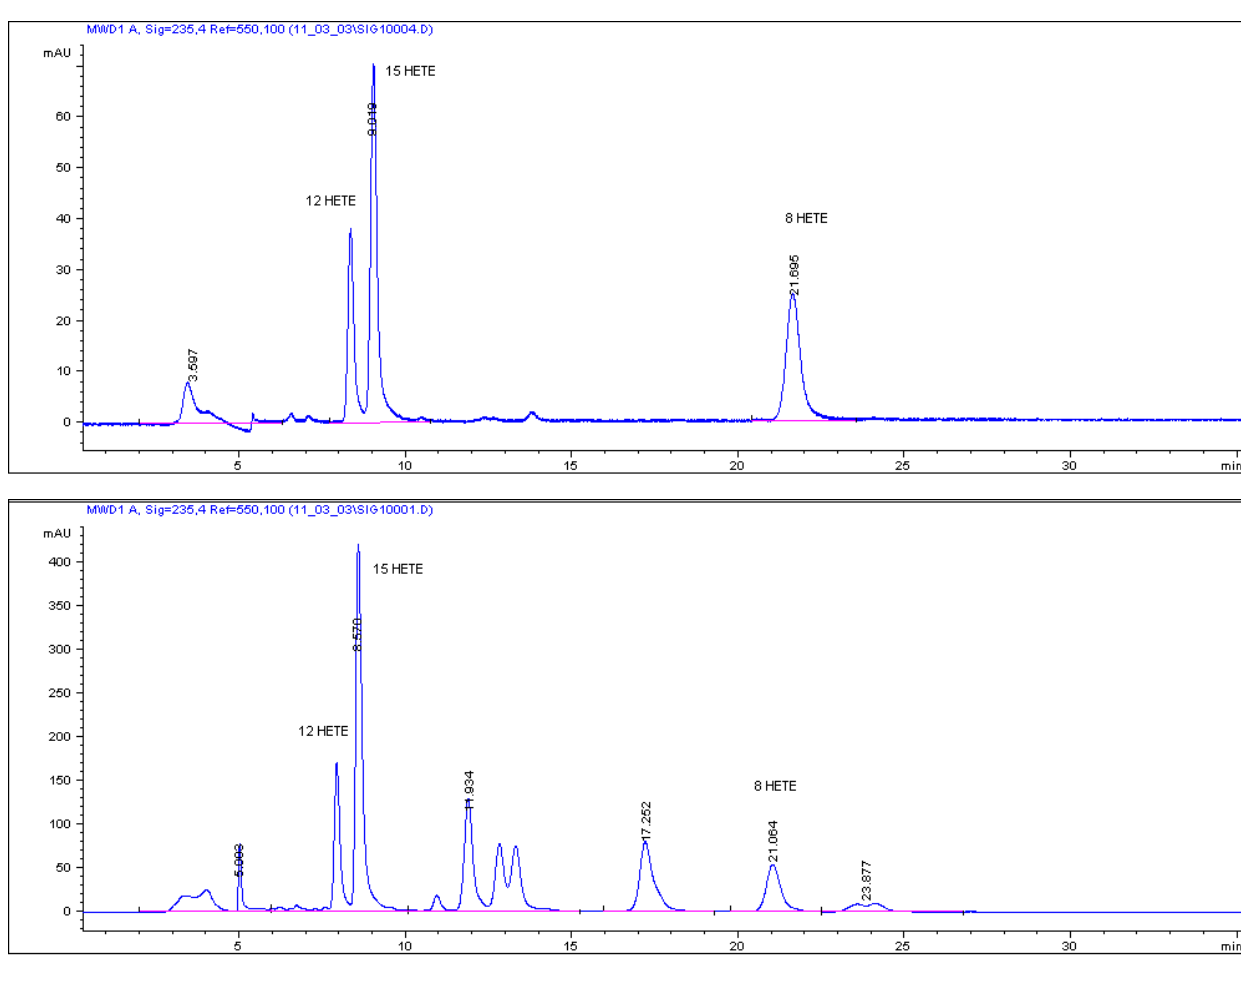
Figure 3. HPLC chromatogram of 8-,12- and 15-HETE standards (upper) and incubate of AA with purified enzyme